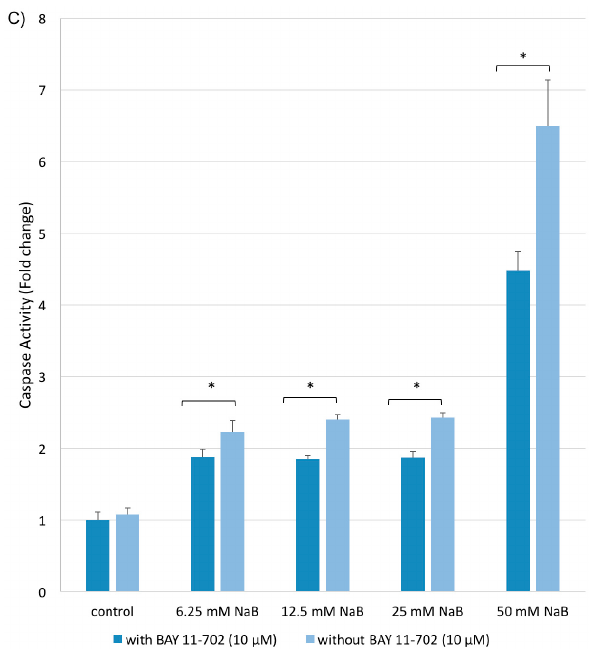
Figure 7. Effects of NaB and NaB/BAY 11-7082 treatment on NF κ B activation, cell viability, PARP fragmentation, and Bim and Bcl-xl proteins, in HCT116 colon cancer cells. HCT116 colon cancer cells were seeded to 96 and six well plates and after overnight incubation, cells were treated with or without 10 µ M BAY 11-7082 for one hour before incubation with NaB (12.5–50 mM) for 24 h. At the end of the incubation period, cells in the 96 well plates were incubated with a MTT reagent to determine cell viability; whereas, the cells in the six well plates cells were collected and lysed. Nuclear and total cell fractions were blotted for NF κ B-p65, PARP, Bim, and Bcl-xl proteins and assayed for caspase-3 activity. ( A ) NaB treatment significantly increased nuclear NF κ B-p65 levels and PARP fragmentation in